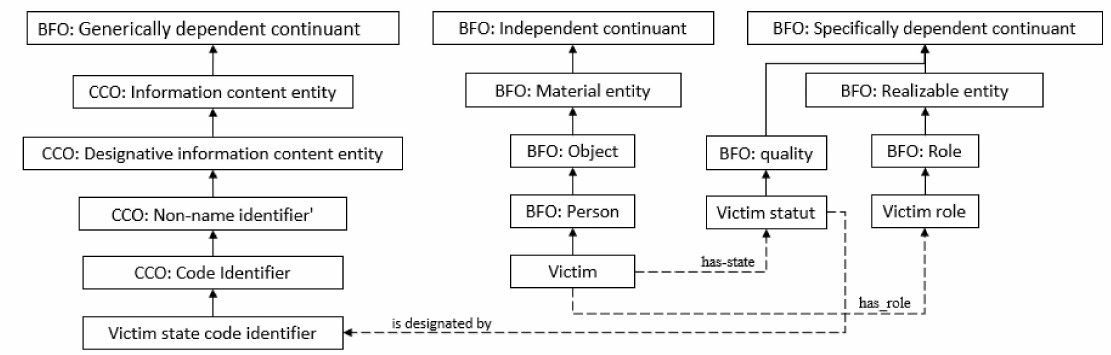
Figure 10. Definition of victims in PCC